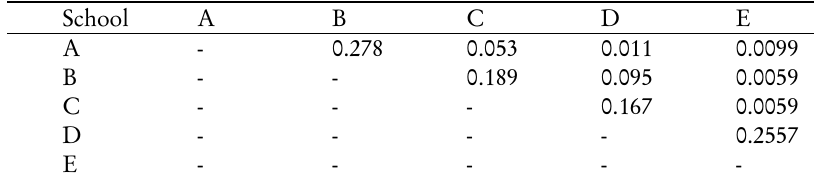
Combined p-values (after multiplicity adjustement) of the pairwise